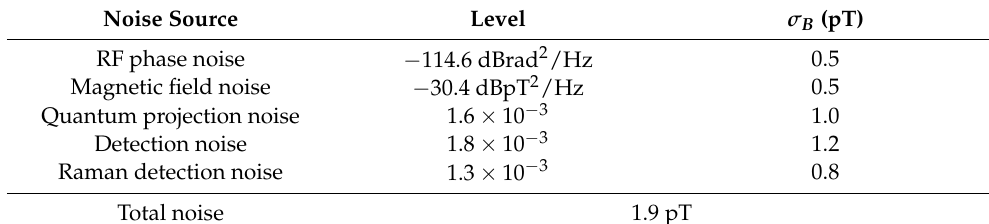
Table 2. List of noise sources and their estimated effect on one-shot